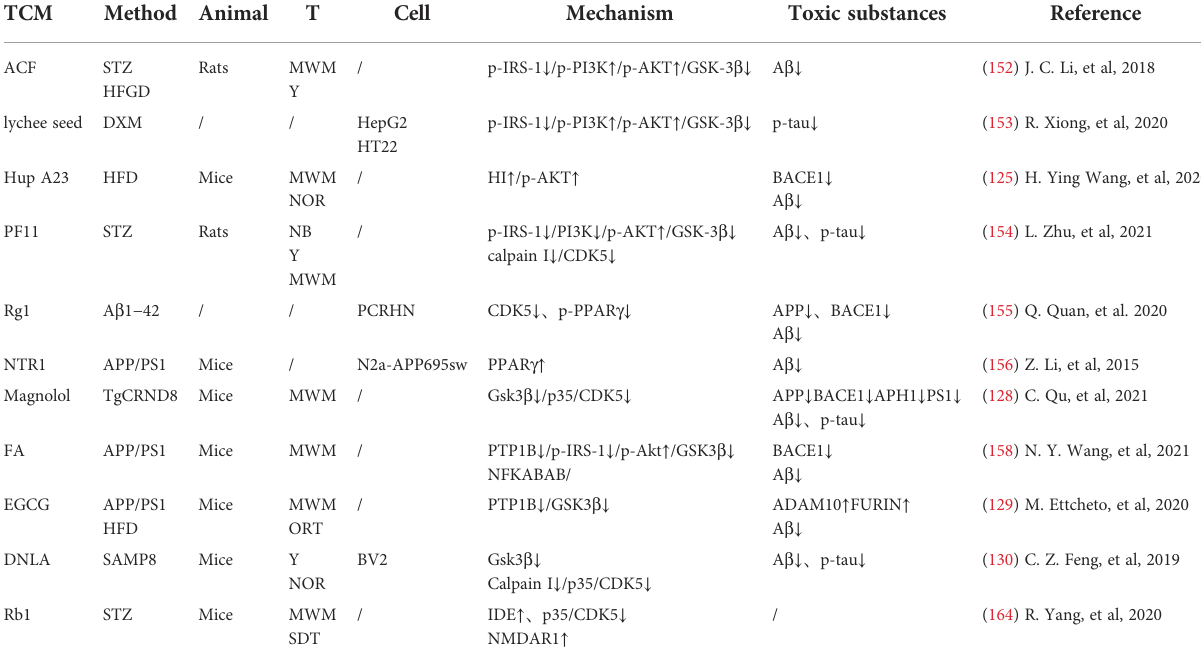
TABLE 3 TCM reduces toxic substances through insulin signaling